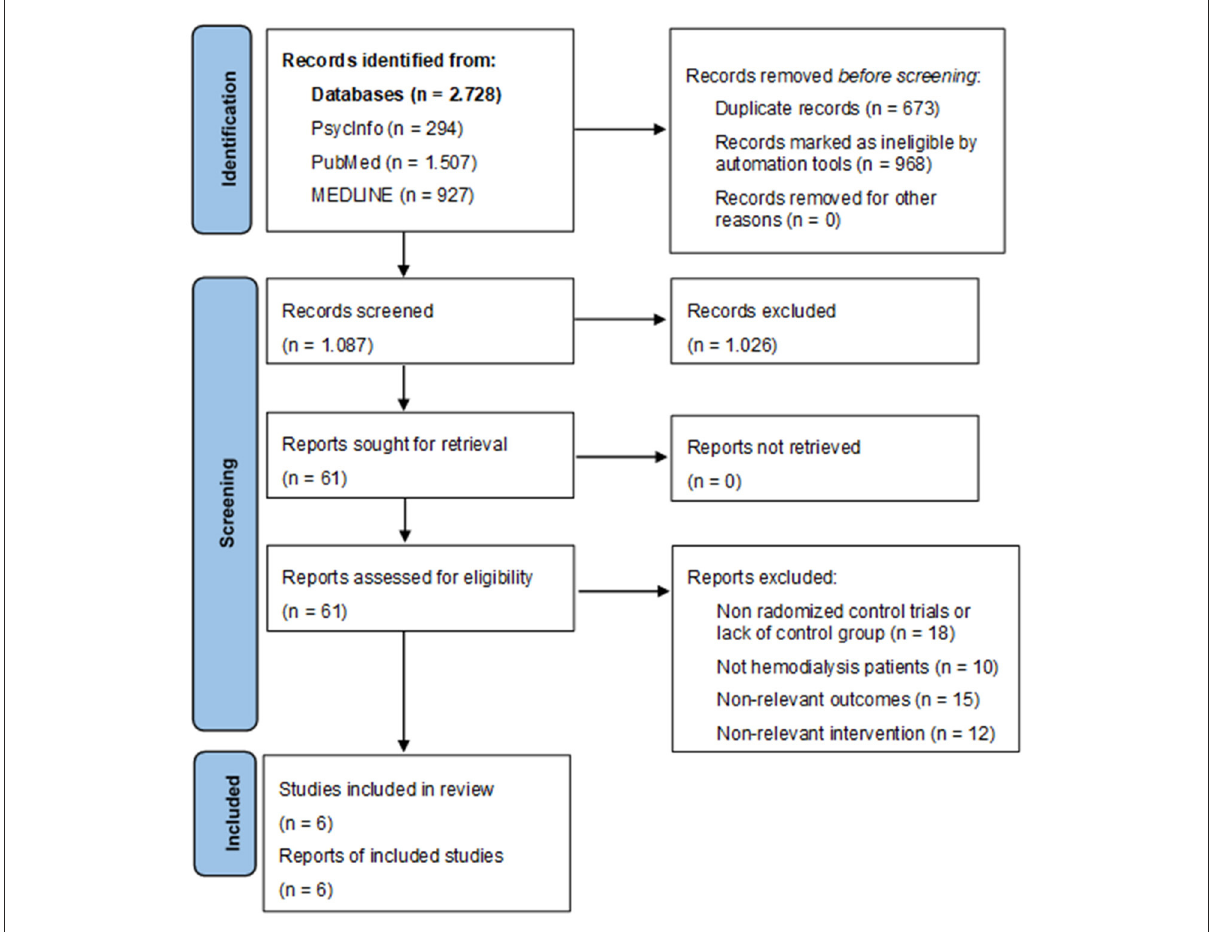
FIGURE1 PRISMA flow